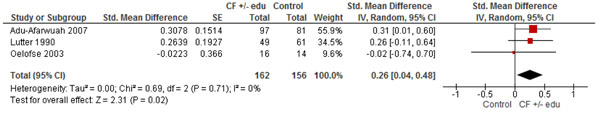
Forest Plot for the effect of complementary food with or without education: WAZ scores: Food insecure population